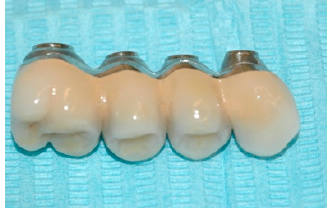
Figure 10. The built superstructure.